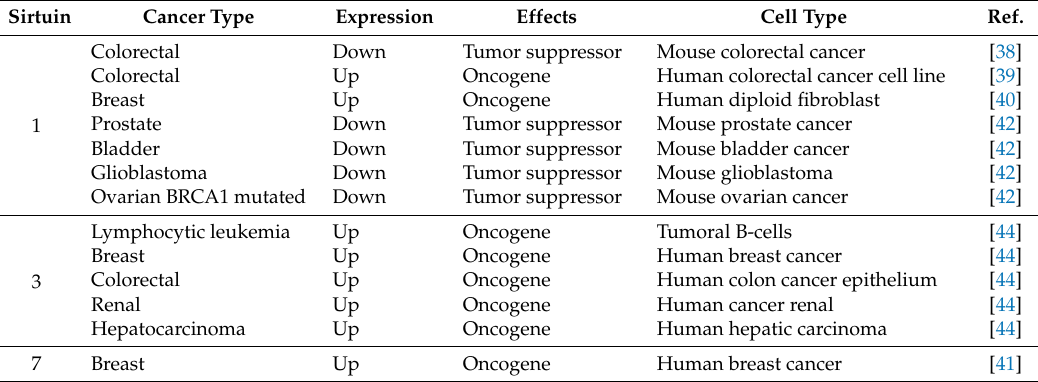
Table 1. Sirtuins regulation and function in selected